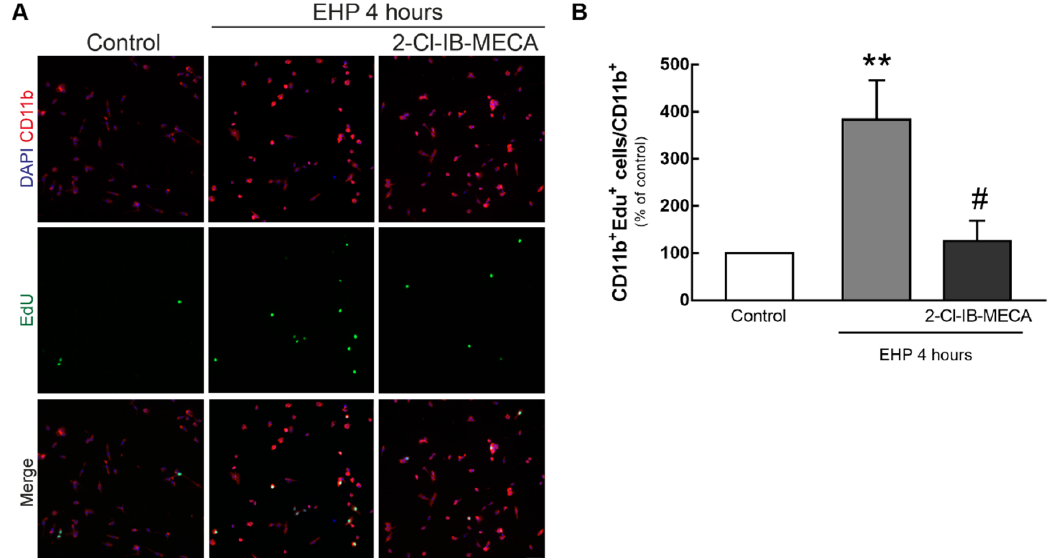
Figure 7. Effect of A 3 R activation in EHP-induced proliferation of primary retinal microglial cells. Cells were incubated with 1 µM 2-Cl-IB-MECA and then exposed to EHP for 4 h. Cell proliferation was measured by counting the number of EdU + cells (green). ( A ) Microglial cells were labeled by immunocytochemistry with anti-CD11b. Nuclei were stained with DAPI (blue). Representative images are depicted. Scale bar: 50 µm. ( B ) The number of proliferating microglial cells (EdU + CD11b + ) was counted, normalized to the total number of microglia and expressed as percentage of the control from 5 independent experiments. ** p < 0.01, compared with control, # p < 0.05, compared with EHP, Kruskal–Wallis test, followed by Dunn’s multiple comparisons test.